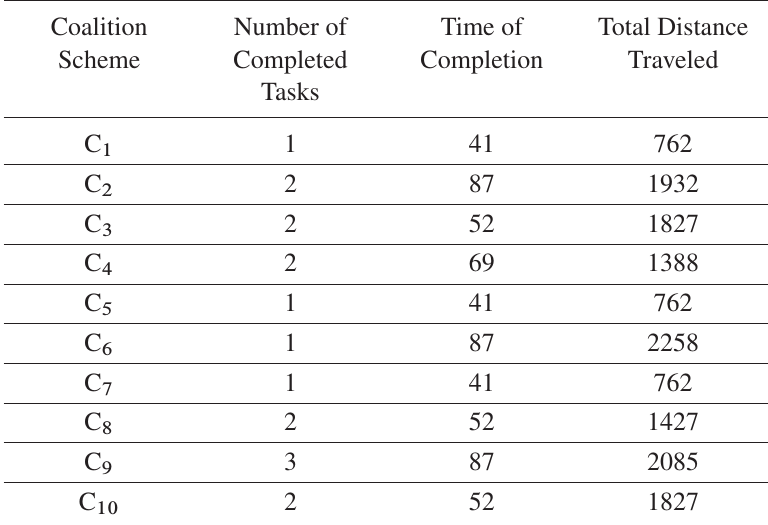
Table 1. Initial fitness